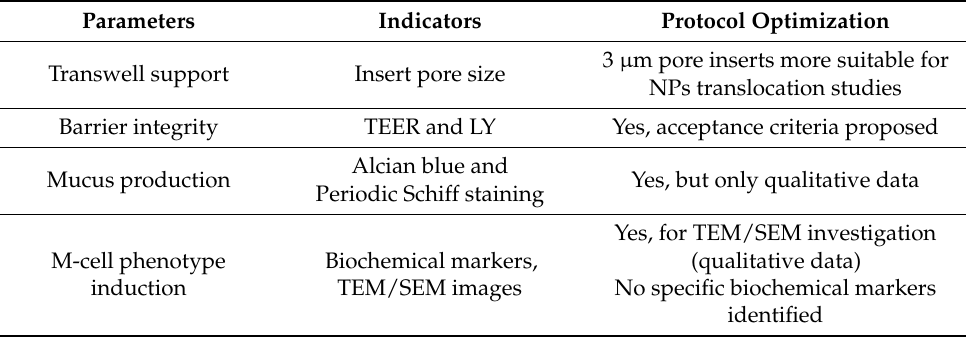
Table 2. Summary of the main parameters and indicators investigated in the